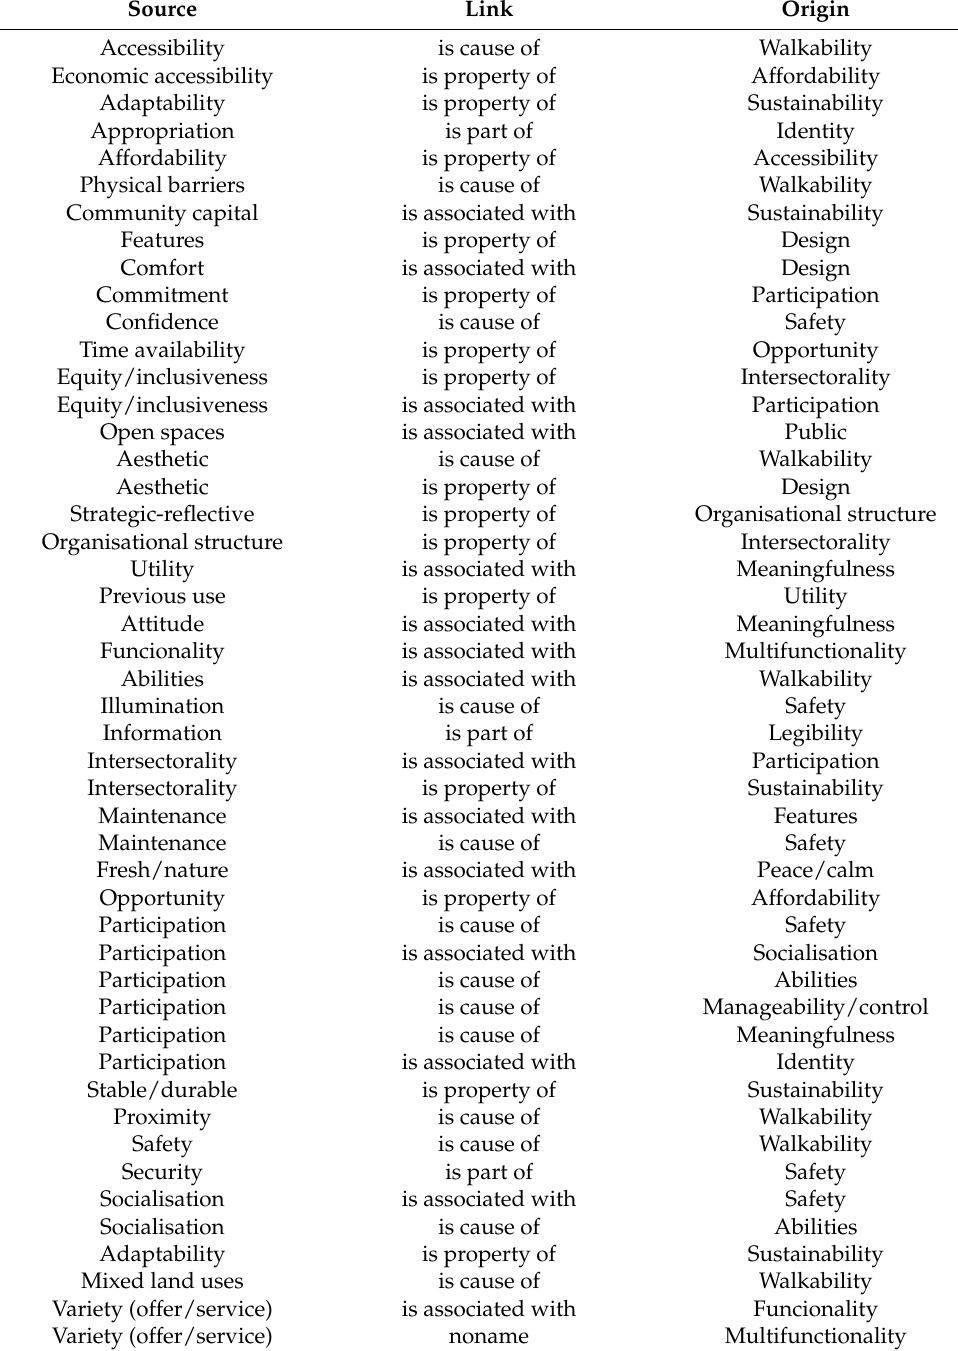
Table 2. Concepts and concurrences identified in the content analysis.